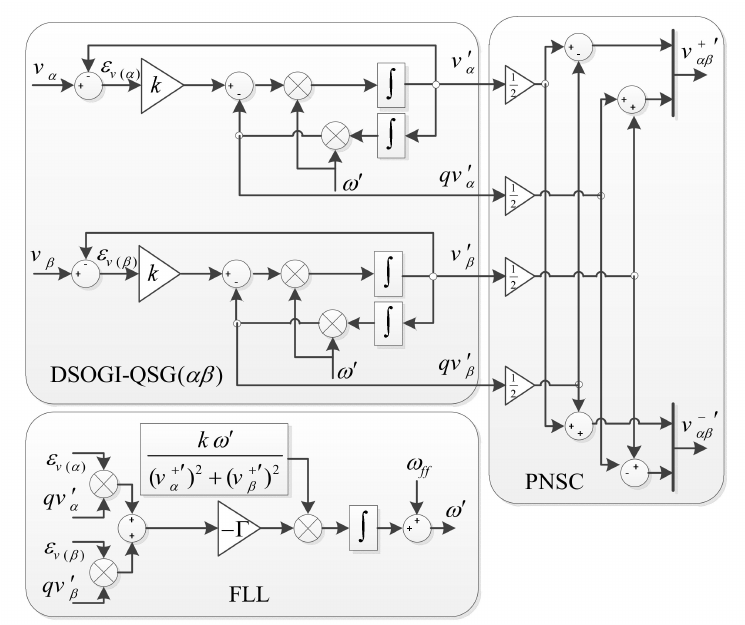
Figure 2. Block diagram of the double second-order generalized integrator frequency-locked loop (DSOGI-FLL) divided into its building blocks: second-order generalized integrator-quadrature signal generator (SOGI-QSG) ( β ), SOGI-QSG ( α ), FLL and positive–negative-sequence calculation (PNSC).